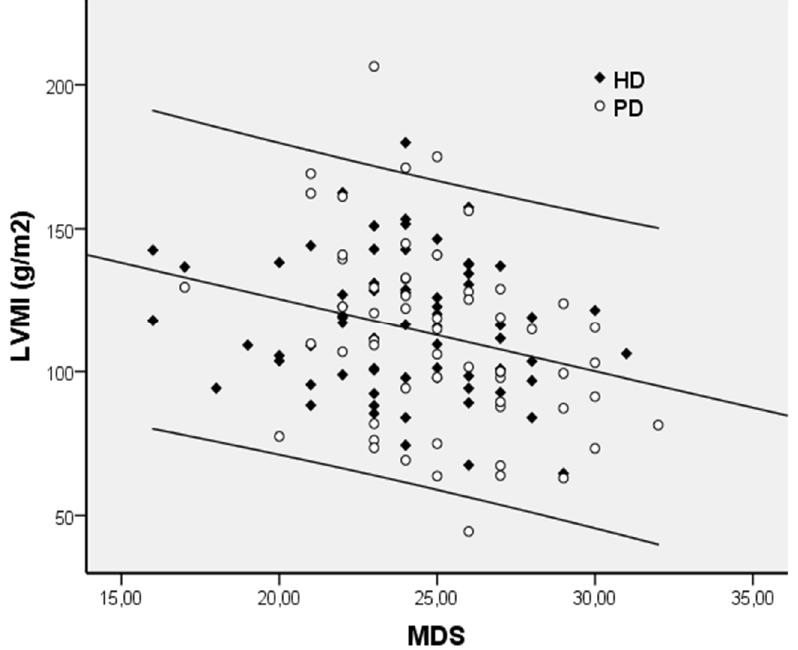
Figure 1. The correlation between left ventricular mass index (LVMI) and Mediterranean diet score (MDS); HD, Hemodialysis; PD, Peritoneal Dialysis. Table 4. Predictors of the left ventricular mass index (LVMI) assessed through multiple regres- sion